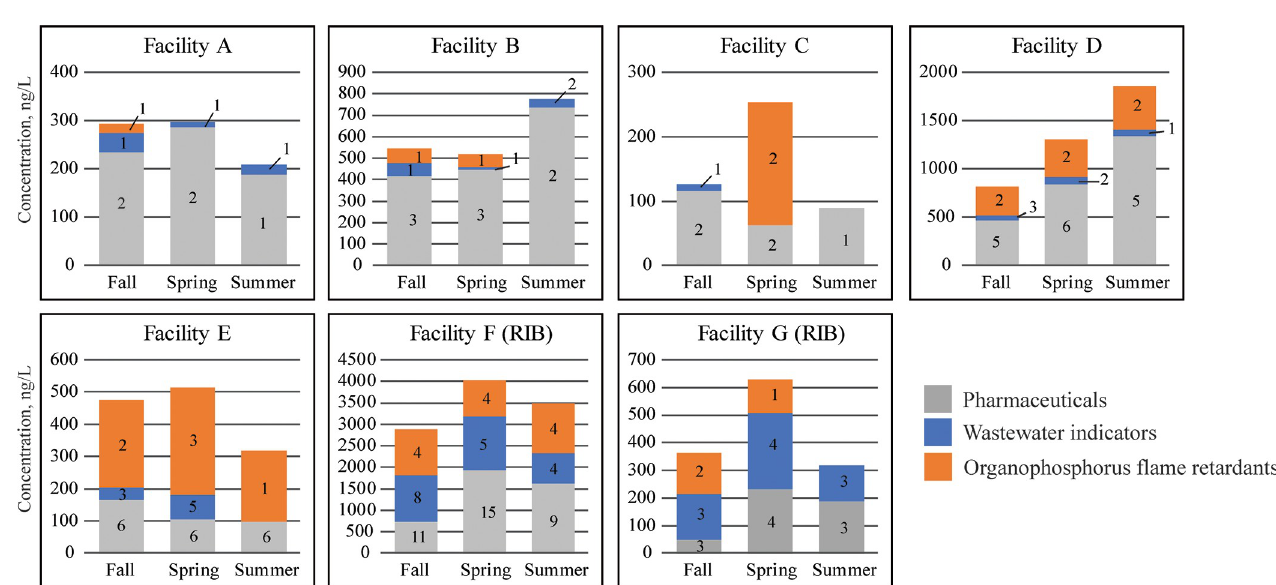
Fig 2. Total micropollutant concentrations detected in groundwater downgradient from large subsurface treatment systems and rapid infiltration basins. Numbers in bars indicate the number of micropollutants detected within that class.